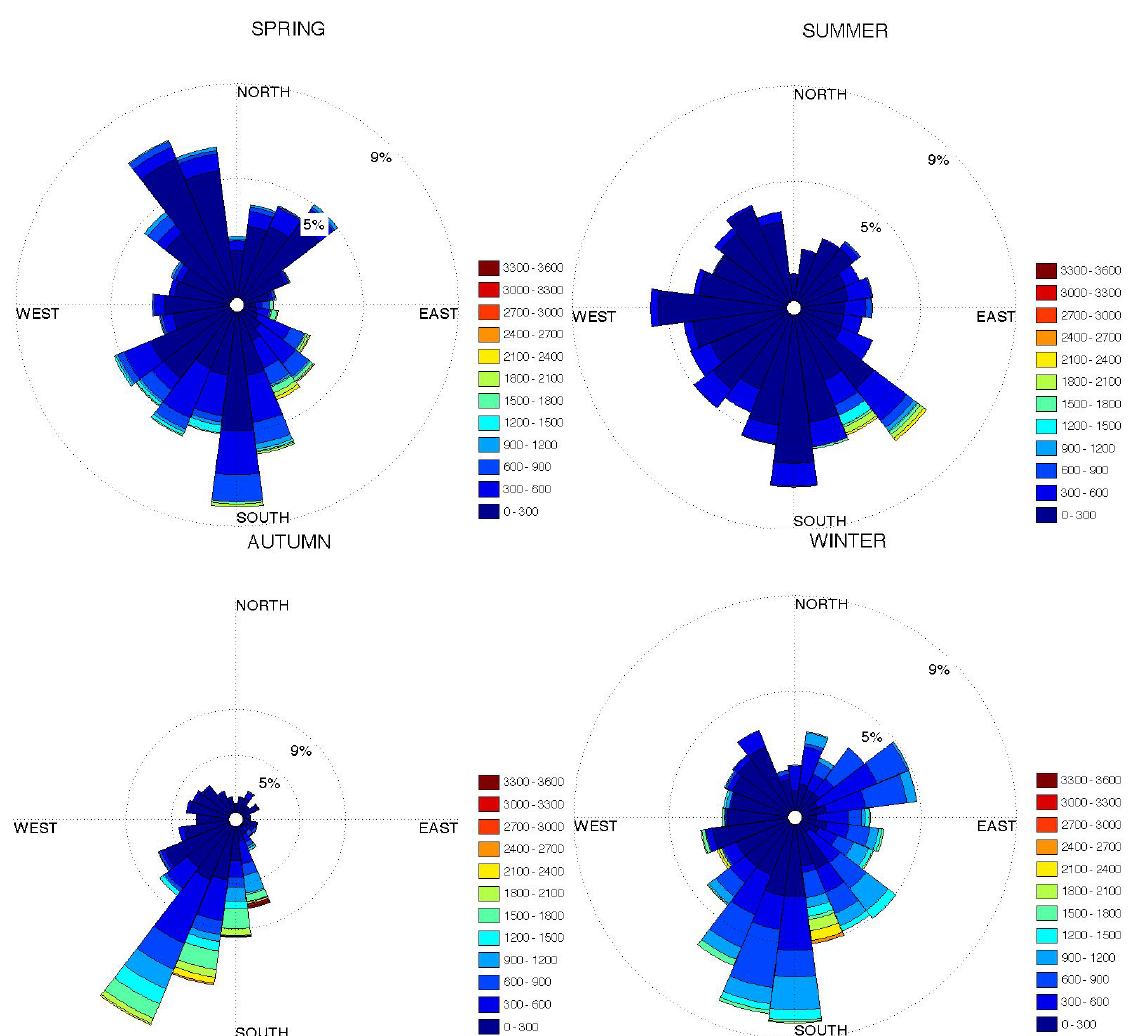
Fig. 10. The measured seasonal wind directions (slices) and BC concentrations represented as a colour scheme (Hyyti¨al¨a 2005).